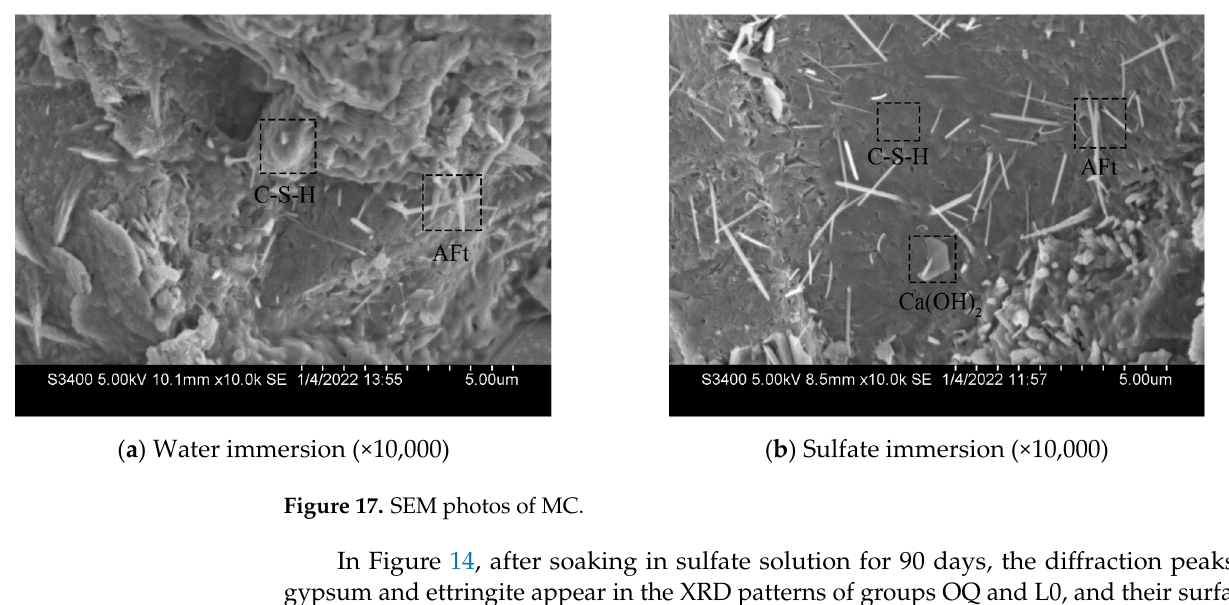
Figure 16. SEM photos of Group MD and 0C’s erosion products.